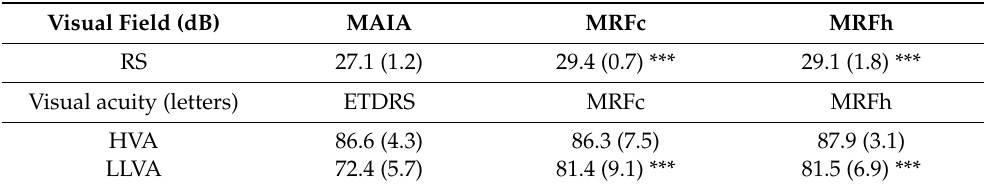
Table 4. Group averages (SD in brackets) for visual acuity (ETDRS vs. MRFh) and visual field (MAIA vs. MRFh) after 12-months of home monitoring.